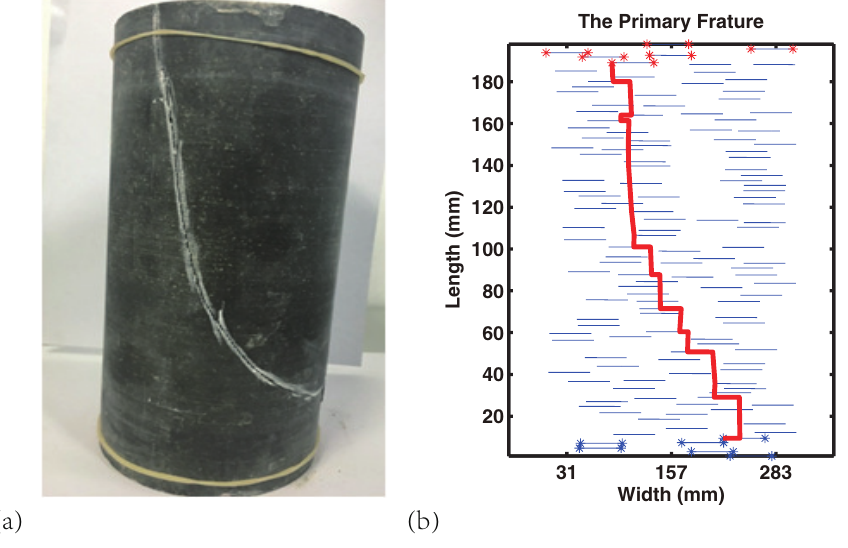
Figure 11. ( a ) the failure morphology of the sample; ( b ) the simulated